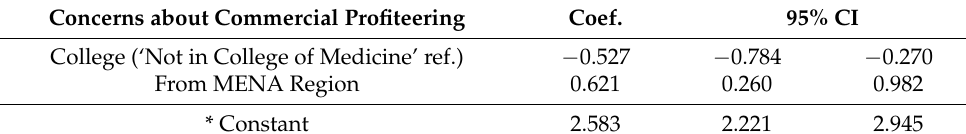
Table 5. Linear regression model of Concerns About Commercial Profiteering. Concerns about Commercial Profiteering Coef.